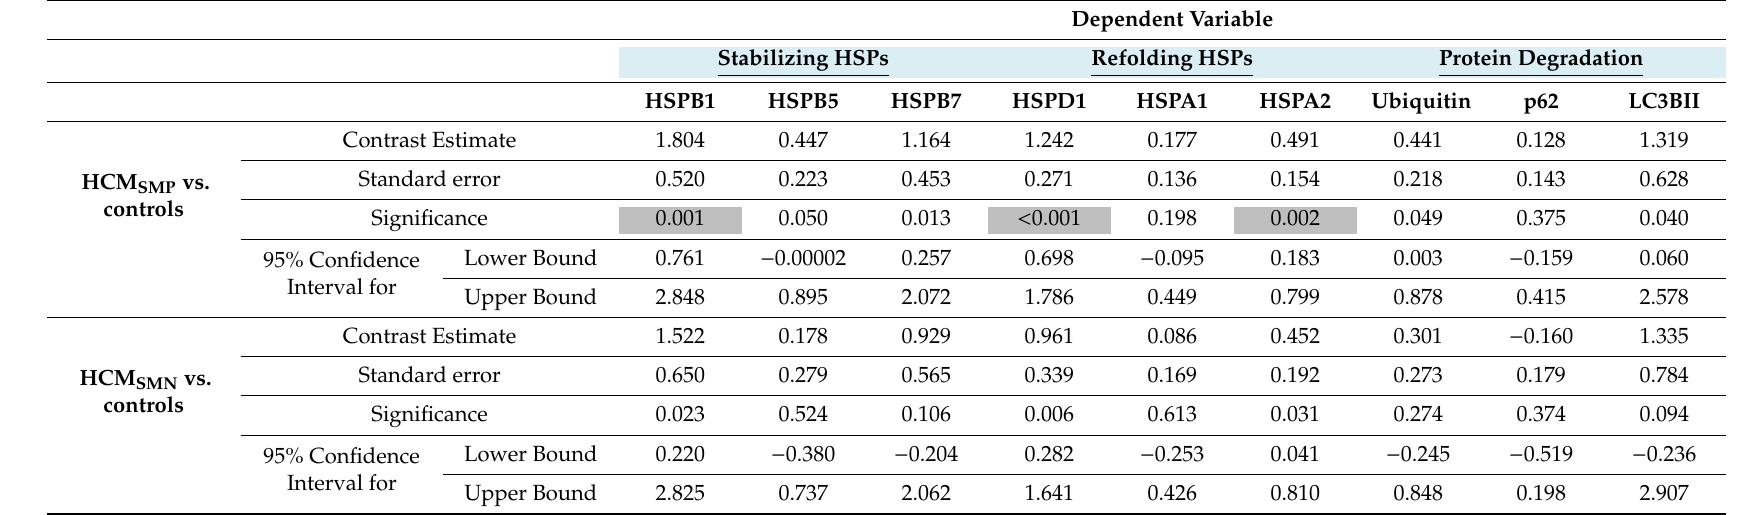
Table 5. Simple Contrast Results (K Matrix) for HCM grouping (controls, HCM SMP , HCM SMN ) as an e ff ect and correction for di ff erences in age at operation and sex.